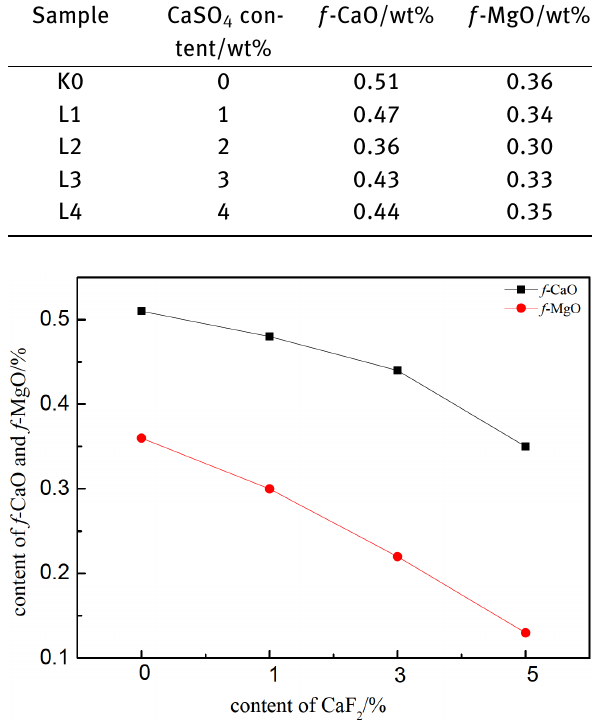
Figure 3: Effect of CaF 2 on the f -CaO and f -MgO contents in the reconstructed steel